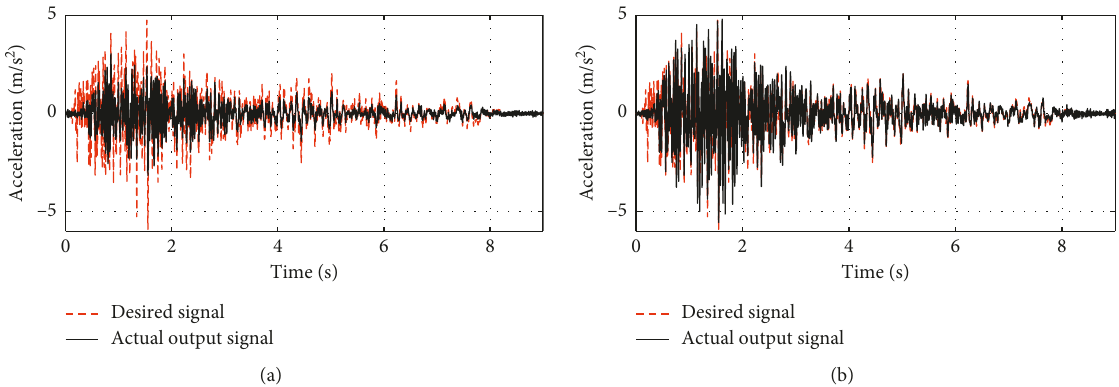
Figure 9: Comparison of the output signal and desired signal of the Taft earthquake with 0.50 g PGA. (a) Output without iteration; (b) output with 4 iterations.